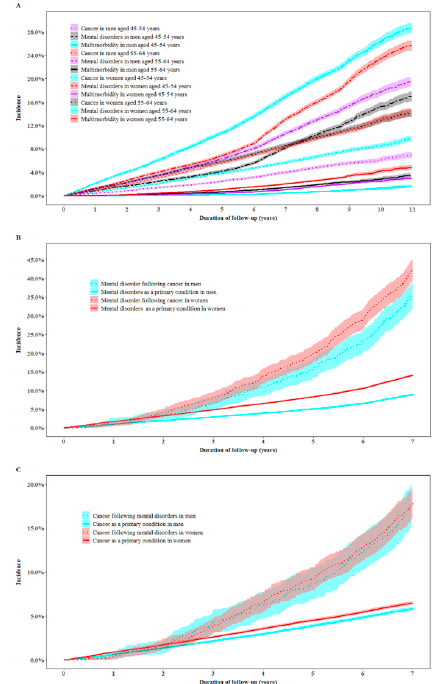
Figure 1. Incidence of cancer, mental disorders, and multimorbidity in middle-aged men and women. ( A ) The cumulative incidence of cancer, mental disorders, and multimorbidity in men and women by age groups. Cox proportional regression models were used to examine whether the incidence of cancer and mental disorders multimorbidity di ff ered by gender and by age groups after adjustment for the country of birth, income, education, health insurance, lifestyle factors, medical history, family history of conditions, BMI (body mass index), self-rated overall health, and quality of life (gender and age were mutually adjusted for). ( B ) The incidence of mental disorders within seven years in individuals with cancer and in the general population by age and gender groups. ( C ) The incidence of cancer within seven years in individuals with mental disorders and in the general population by age and gender groups. To enable comparison, the onset of the primary and secondary condition participants with follow-up time < 7 years for the secondary condition were excluded. A cut-o ff point of seven years was used because the third quartile of the onset time of cancer since baseline was 7.0